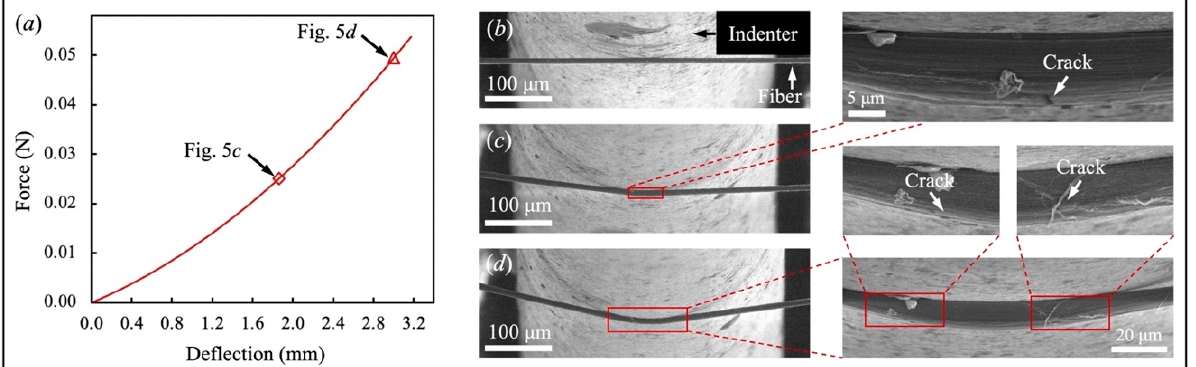
Figure 5. Failure behavior of a representative CNT fiber. ( a ) Force-deflection curve; Real-time fiber morphology at S tr = ( b ) 0; ( c ) 1.862 mm; ( d ) 3.003 mm.